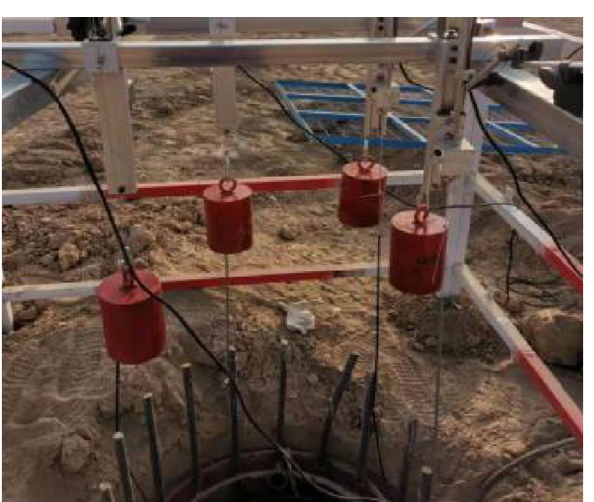
Figure 4. Displacement measuring